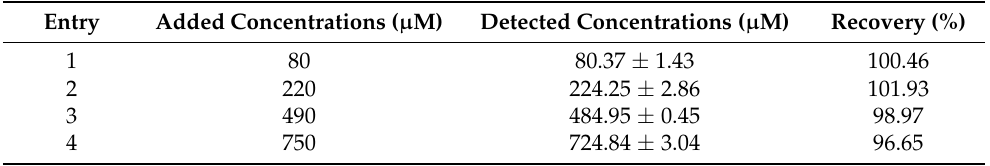
Table 1. Detection of L -lysine concentrations in natural mineral water for drinking. L -lysine with known concentrations was added into the natural mineral water for drinking. The concentration of PQP-1 was 10 µ M. The data come from three parallel